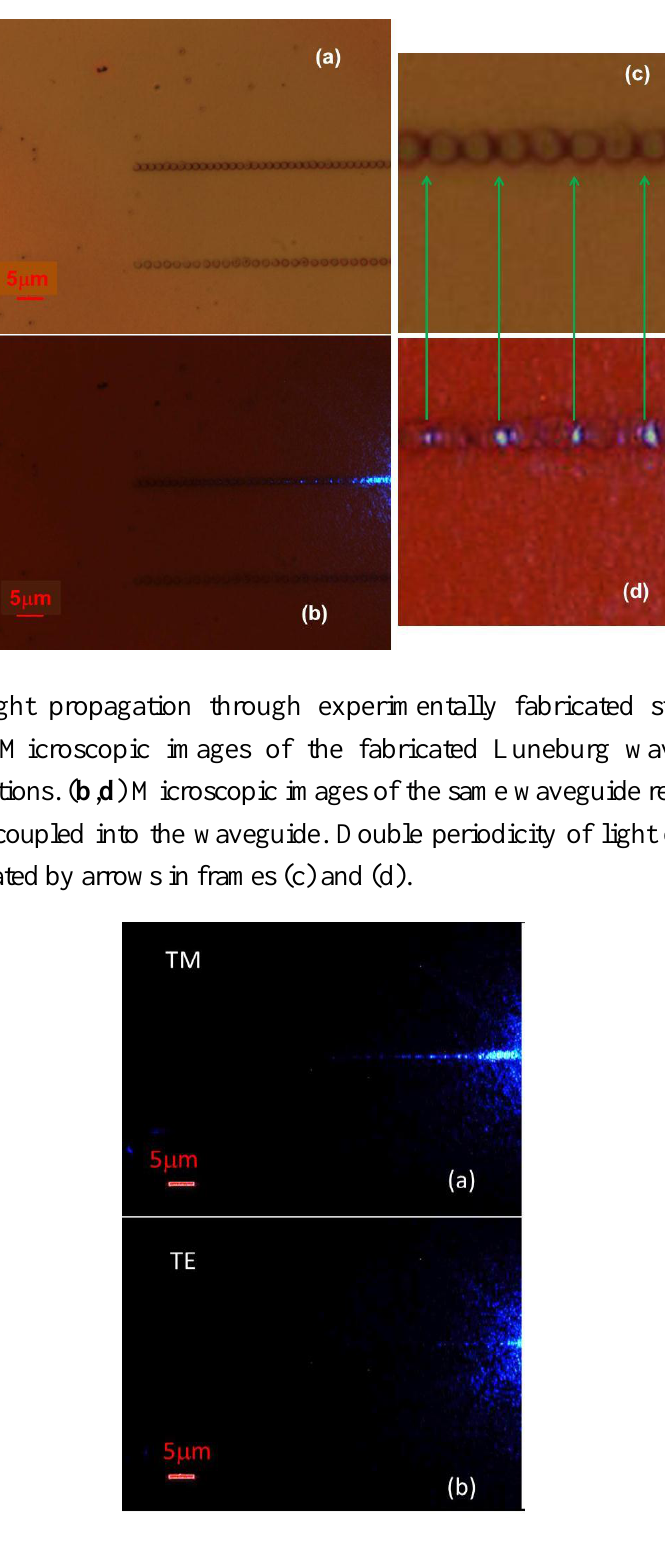
Figure 5. TM Microscopic images of light propagation through the Luneburg waveguide taken using ( a ) TM and ( b ) TE polarized